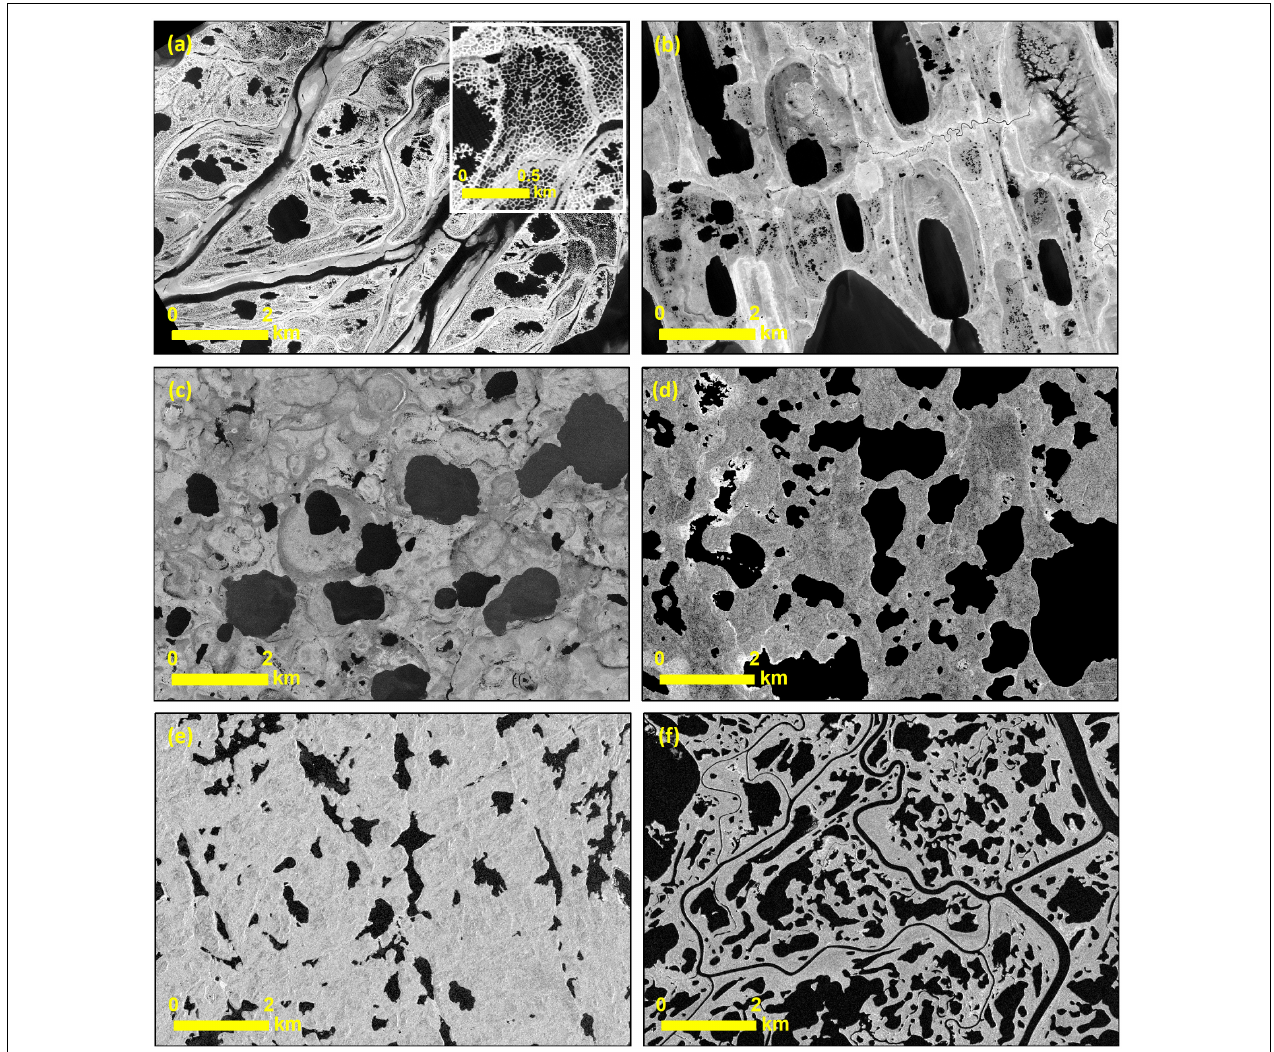
FIGURE 2 | Waterbody patterns in different permafrost regions. (a) First terrace, Lena Delta, Russia – inset shows details of typical polygonal ponds; (b) Wainwright Lower Coastal Plain, Barrow Peninsula, Alaska; (c) Tanzin Lake Uplands, Canada; (d) Mackenzie Delta West, Canada; (e) Kotzebue Sound lowlands, Seward Peninsula, Alaska; and (f) Eskimo Lakes, Canada. Images (a,b) show the near-infrared band from KOMPSAT-2. Image (e) shows near-infrared image from SPOT-5. Images (c,d,f) are TerraSAR-X images© DLR